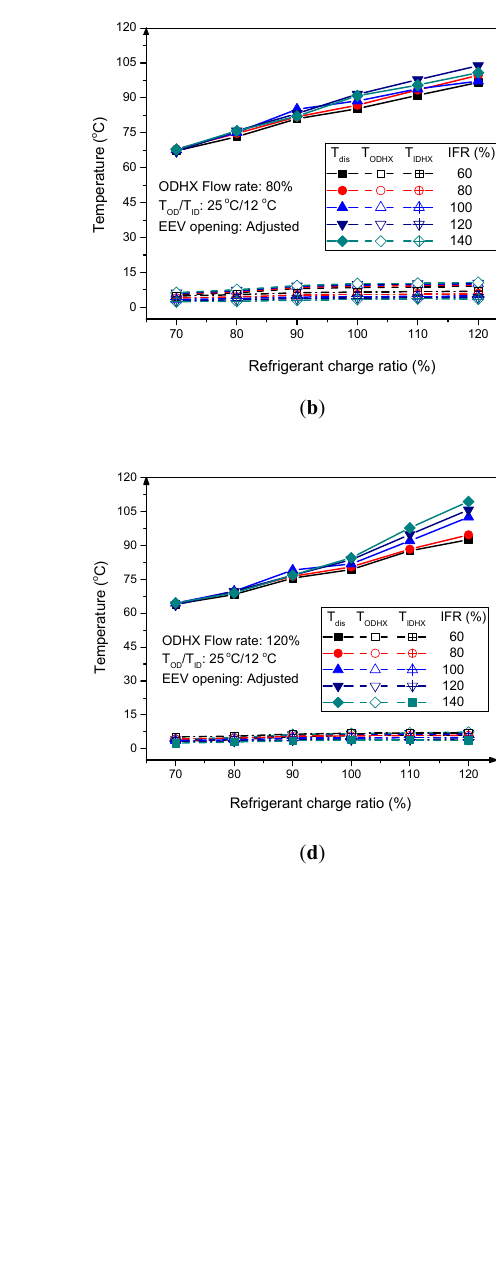
refrigerant charge ratio, IFRF and OFRF within an error threshold of ± 7.3%, ± 7.4% and ± 7.7 as shown in Figures 11–13, respectively. Figure 14 shows a block diagram of the FDD algorithm for the simultaneous refrigerant charge and flow rate faults discussed in this study. The proposed algorithm is applied when the heat pump is operating at steady state.